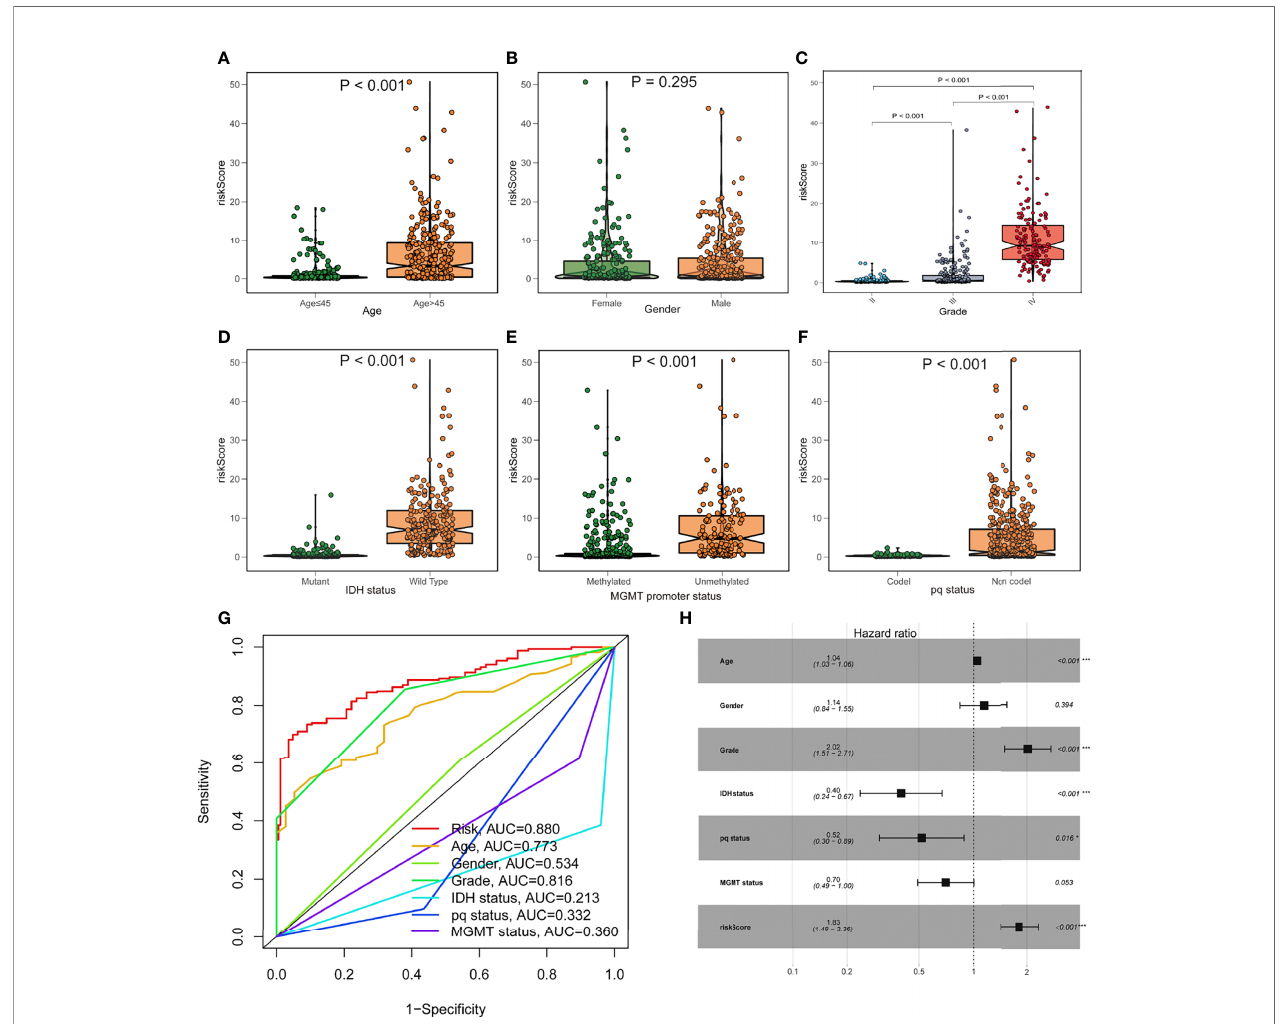
FIGURE 4 | Prognostic value of the fatty acid metabolism score model in glioma patient survival. (A – F) The association between risk score and clinicopathological variables such as age (A) , gender (B) , grade (C) , IDH1 status (D) , MGMT promoter status (E) , and pq status (F) . (G) ROC curves are used to assess the predictive power of clinical characteristics. (H) The forest plot of the TCGA cohort ’ s multivariate Cox regression analysis. *p < 0.05; ***p <